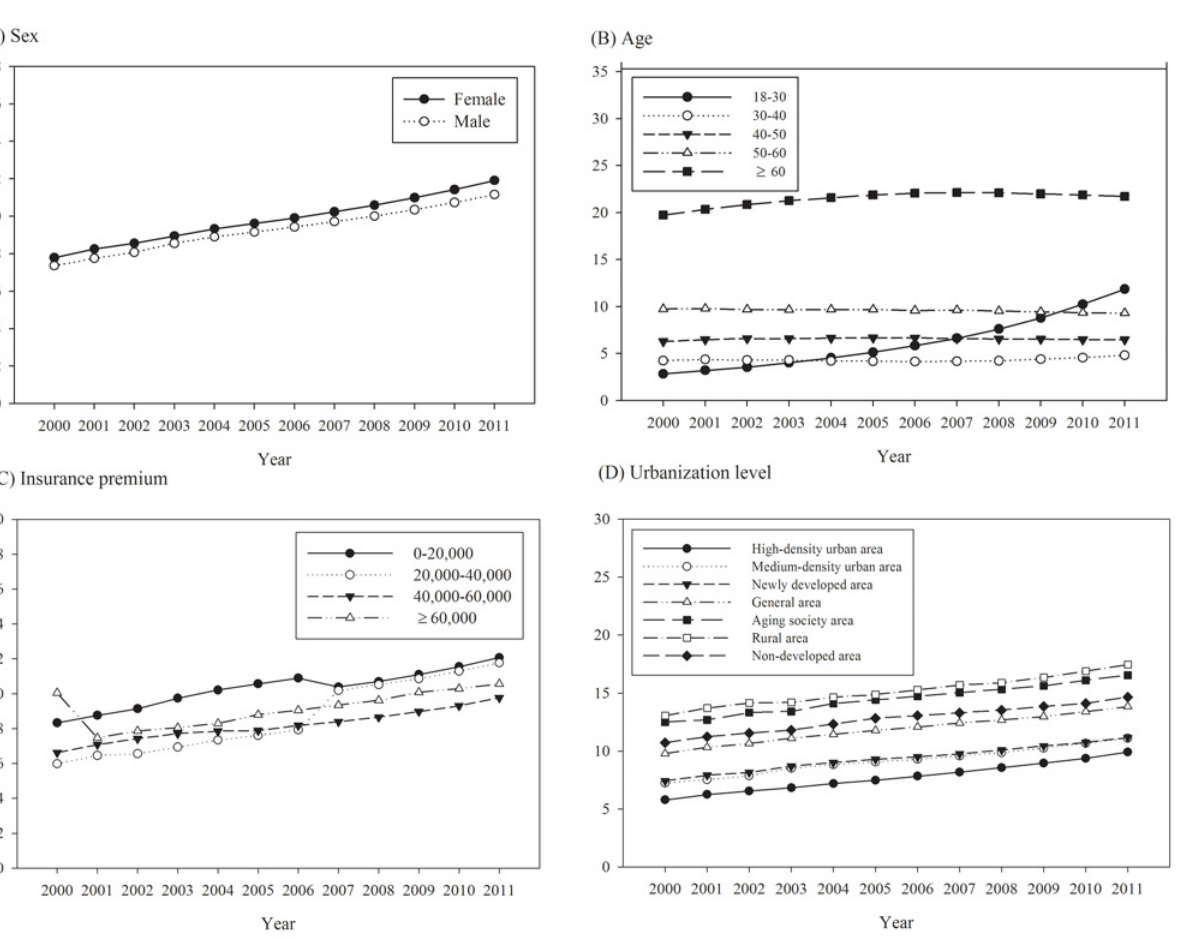
Fig 2. Time trends in the prevalence of asthma stratified by (A) sex (B) age (C) insurance premium (D) urbanization level.